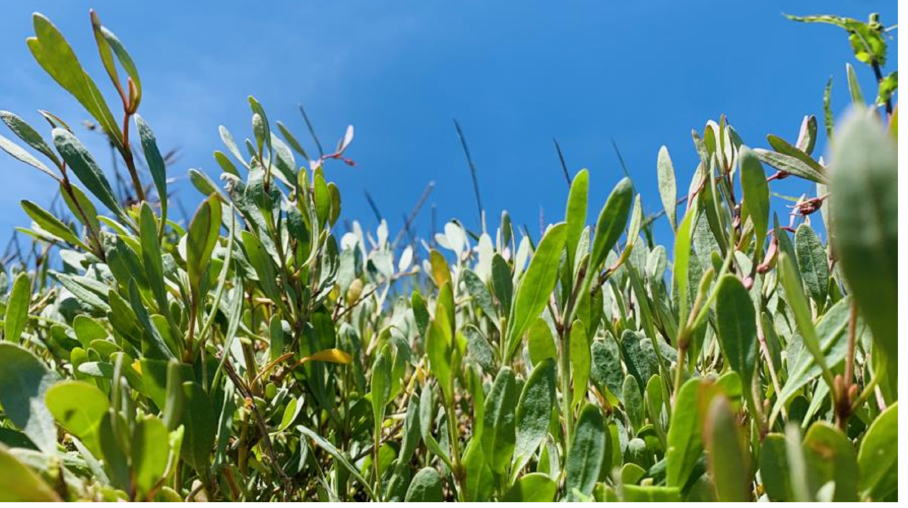
Figure 1. Halimione portulacoides (L.) Aellen, sea